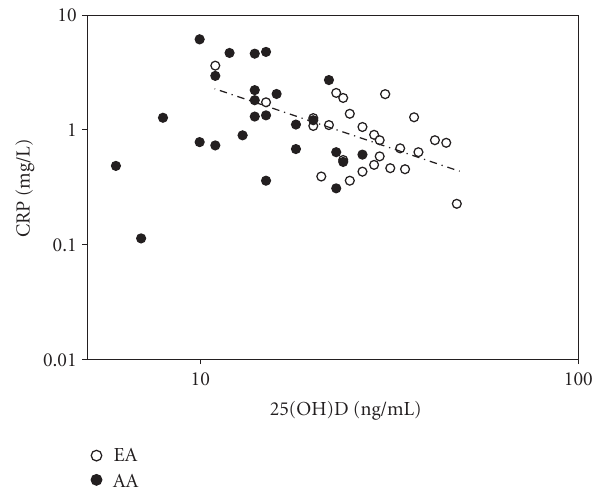
Figure 1: Associations of serum hs-CRP with 25(OH)D. hs-CRP was inversely associated with 25(OH)D ( r = − 0 . 25, P = 0 . 049) as a group. In EA r = − 0 . 544, P = 0 . 004 and in AA, there was no relationship r = 0 . 015, P = 0 . 94.